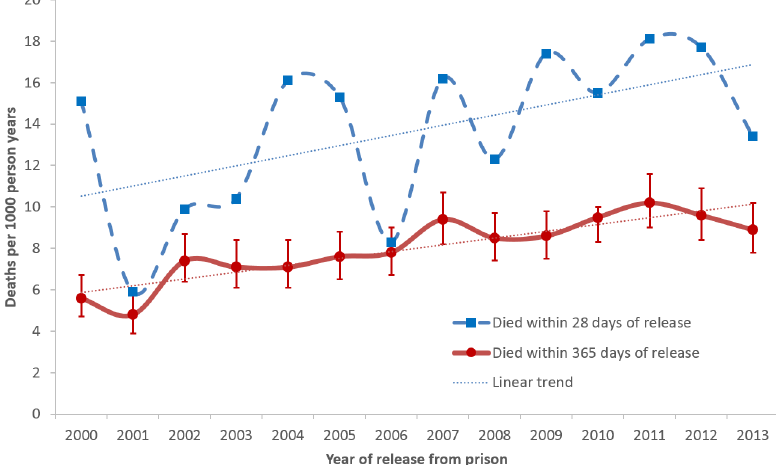
Fig 2. National trend of deaths after release from prison 2000 – 2013, based on Centrelink